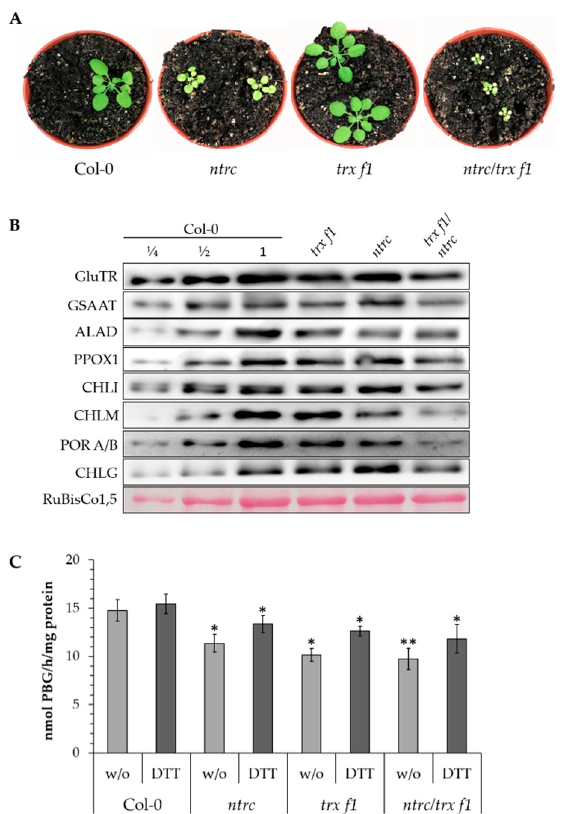
Figure 3 . Redox control of tetrapyrrole synthesis (TBS) enzymes in wild type and mutants. ( A ) Four-week-old seedlings of wild type, ntrc, trf f1 and ntrc/trx f1 mutants. The plants grew under short day conditions (10 h/14 h light/dark) at 120 µmol photons m − 2 s − 1 at room temperature. ( B ) Contents of several TBS enzymes in wild-type (Col-0), trx f1 , ntrc and ntrc/trx f1 plants growing under short day conditions for 21 days. GluTR: glutamyl-tRNA reductase, GSAAT: glutamate-1-semialdehyde aminotransferase, ALAD: 5-aminolevulinic acid dehydratase, PPOX1: protoporphyrinogen IX